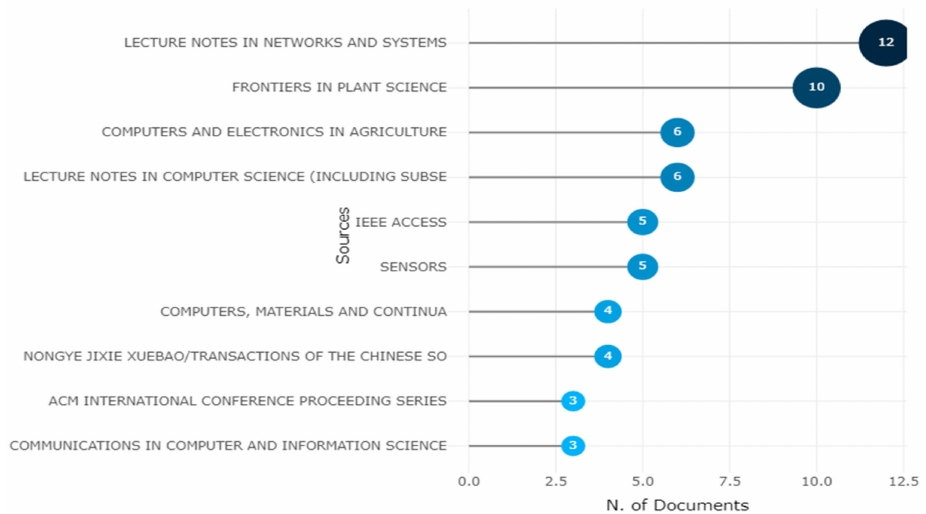
Figure 15. Ten Topmost Relevant Publication Sources of Apple Leaves Disease. Data access informa- tion source: http://www.scopus.com (accessed on 14 September 2022).